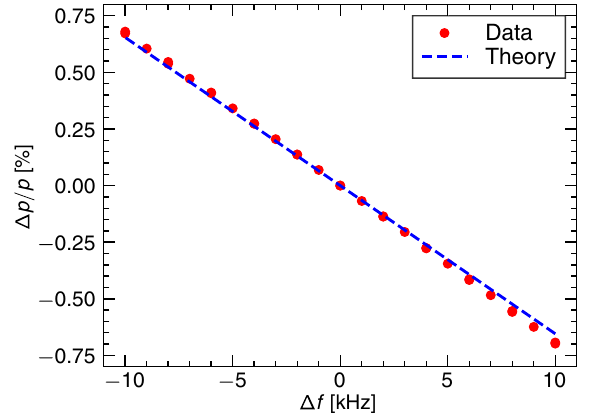
FIG. 9. Momentum offset as a function of rf frequency modulation. The maximum discrepancy between theoretical predictions and measurements is about 4 × 10 − 4 .